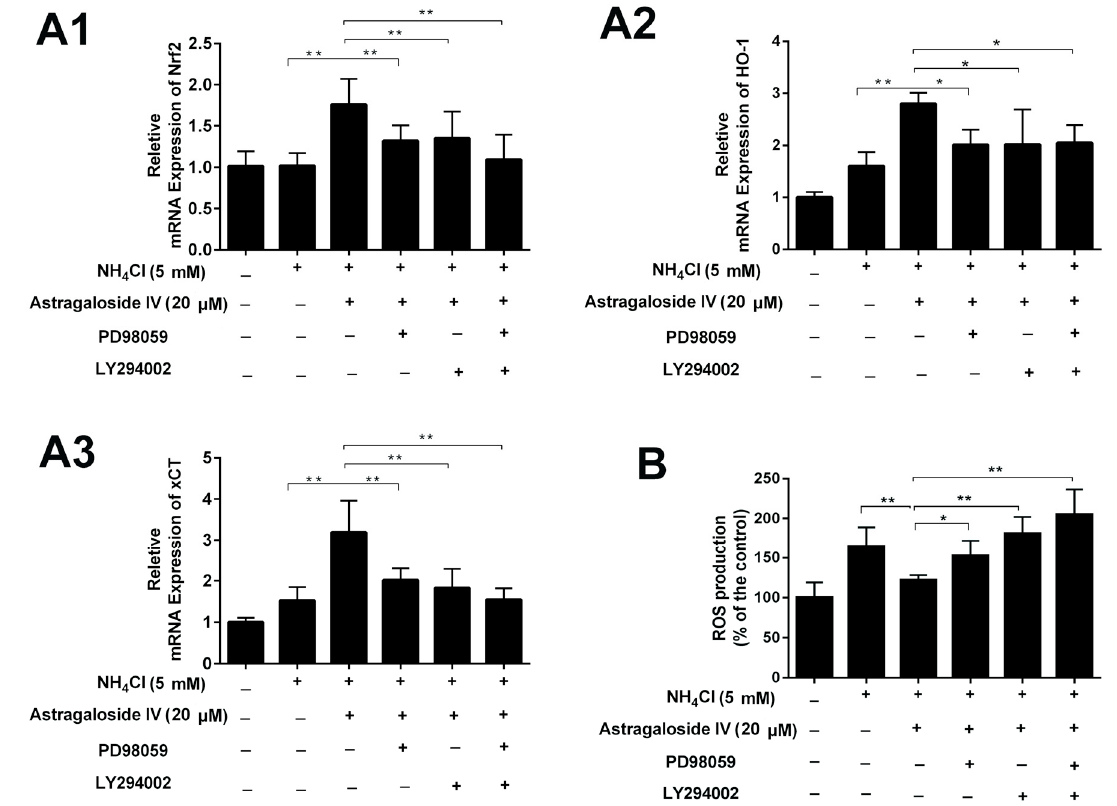
Figure 8. Activations of the ERK and AKT pathways mediate the cytoprotective effects of astragaloside IV against ammonia-induced oxidative stress in MAC-T cells. The cells were preincubated with or without specific kinase inhibitors LY294002 (3 µ M) or PD98059 (10 µ M) for 1 h and were then treated with or without astragaloside IV for another 4 h, followed by ammonia treatment for 24 h. The mRNA expressions of Nrf2 ( A1 ) , HO-1 ( A2 ) and xCT ( A3 ) and the ROS level ( B ) were detected. The data are shown as means ± SD, n = 4; *, p < 0.05; **, p < 0.01.